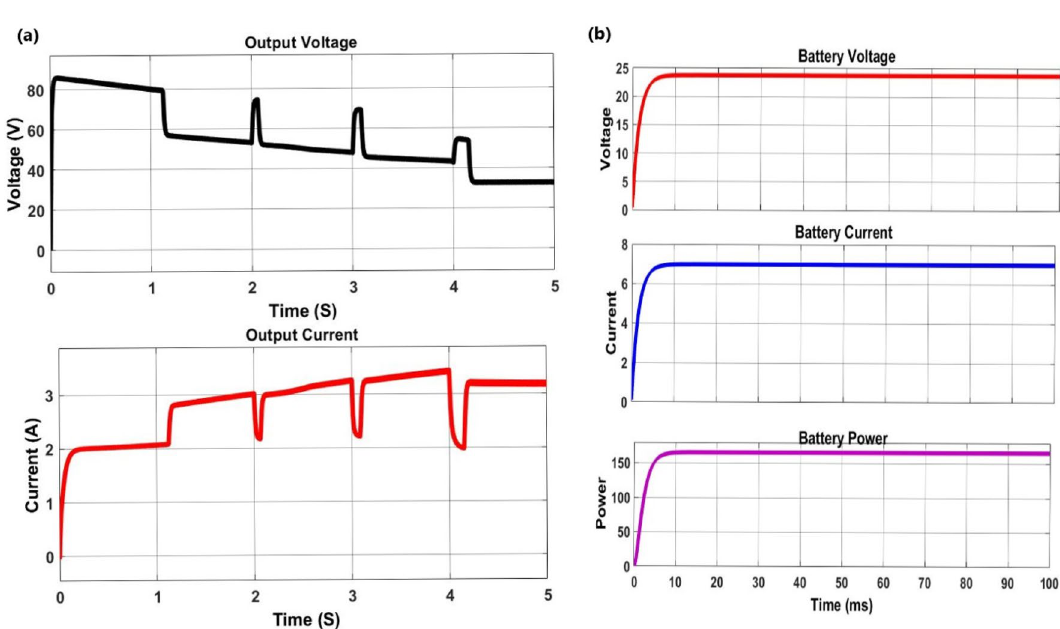
Figure 8. The converter output voltage, and output current are presented because as the converter is dealing with a large load (battery) step from the discontinuous current mode (DCM) to the continuous current mode (CCM), therefore; the transient condition is important ( a ). Battery (Load) current, voltage, and power ( b ).